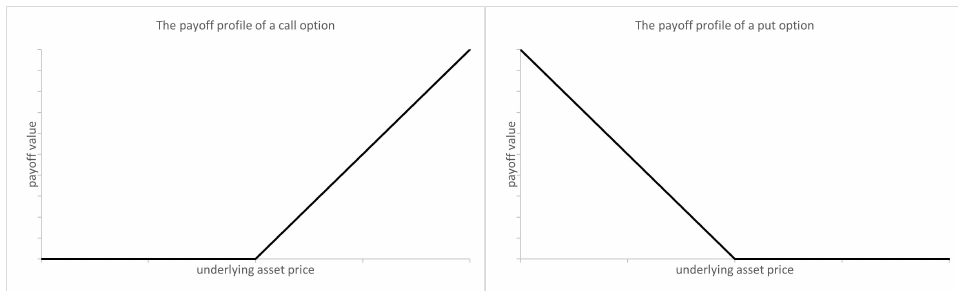
Figure 1. The payoff profiles of call and put